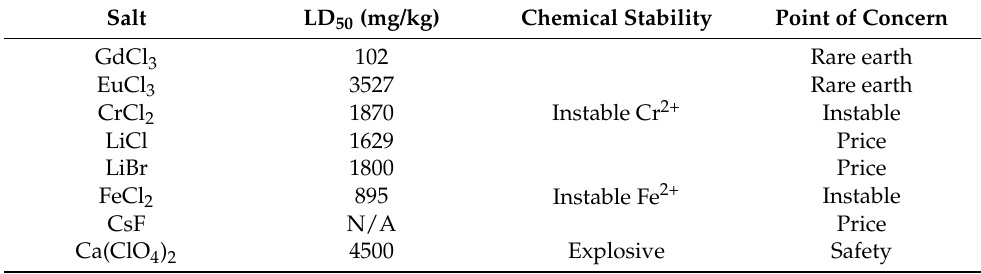
Table 5. LD 50 -values and chemical stability of salts